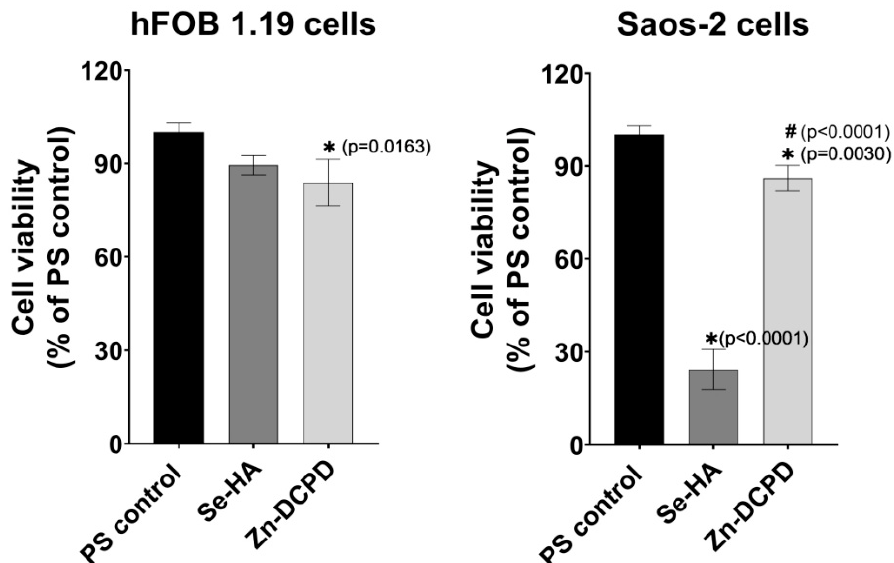
Figure 3. Cytotoxicity assessment by MTT assay after 24-h exposure of foetal osteoblast cell line (hFOB 1.19) cells and human osteosarcoma cell line (Saos-2) cells to extracts of Se-HA powder and Zn-DCPD powder (PS control–negative control of cytotoxicity; * indicates statistically significant results compared to PS control, # indicates statistically significant results compared to Se-HA; One-way ANOVA followed by Tukey’s test).